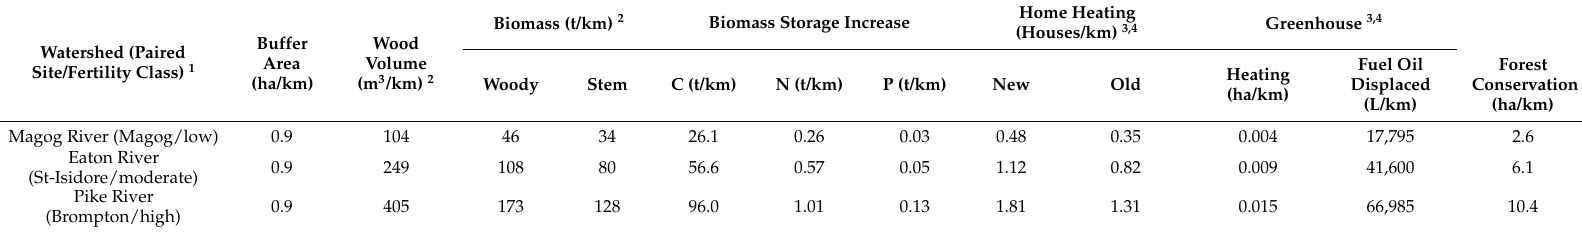
Table 6. Potential ecosystem service provision after 9 years following the replacement of non-managed herbaceous buffers by hybrid poplar buffers along 1 km of stream in three watersheds with contrasted soil fertility. The biomass produced along streams could be used to heat farmhouses instead of fuelwood harvested in natural woodlots, allowing an opportunity for conservation. Alternatively, poplar biomass could be used to heat greenhouses and contribute to displace fossil fuel use.